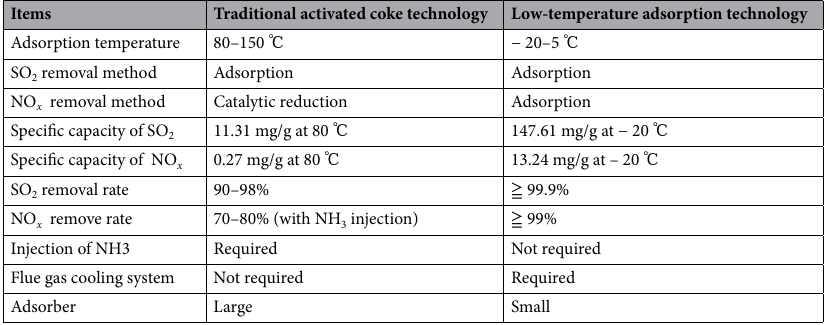
Table 1. Comparison of LAS technology and traditional activated coke technology.